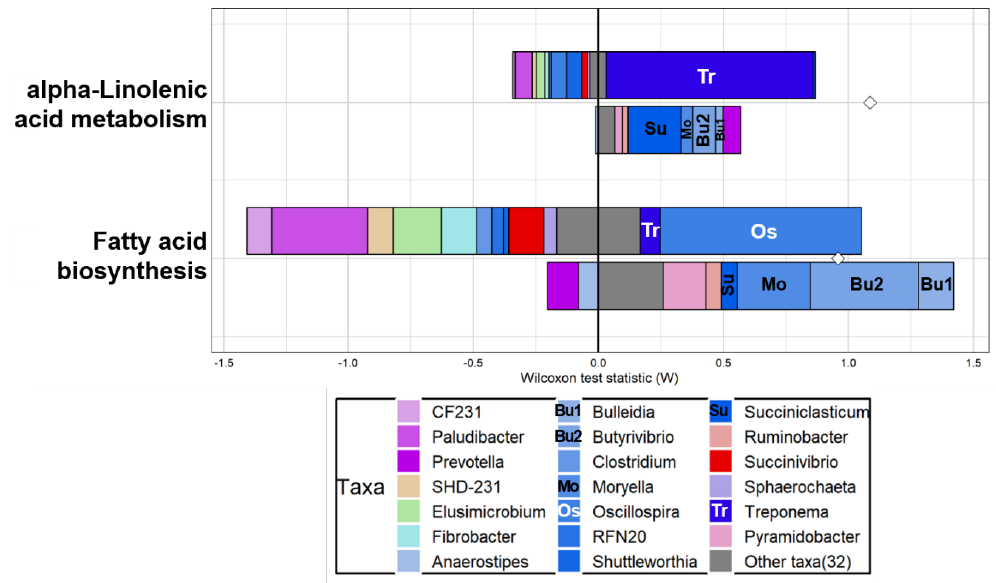
Figure 5. Characterization of taxonomic drivers of two functional pathways related to lipid metabolism in the rumen of the high marbling score (HMS) group of Korean beef cattle using FishTaco.